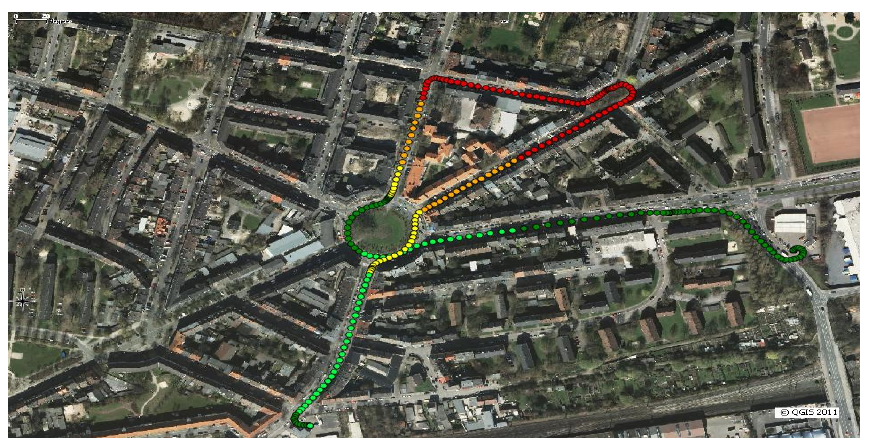
Figure 3. Field data collection path.